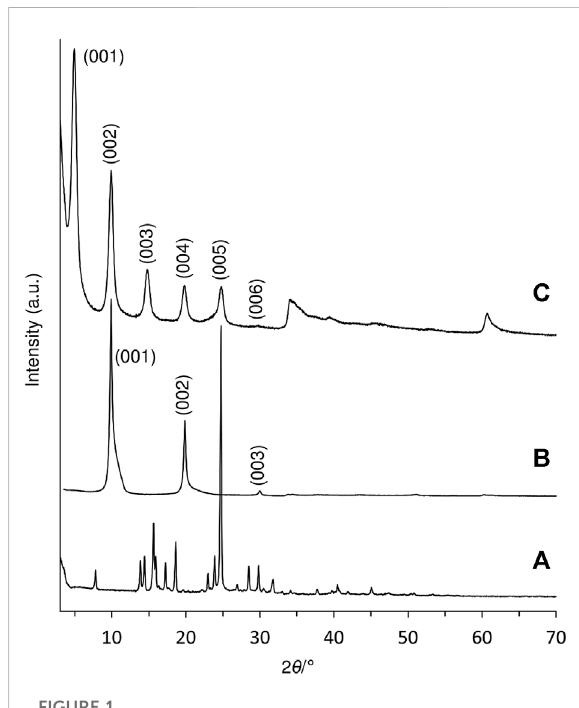
FIGURE 1 PXRDpatternsof (A) ketodiacid 3 , (B) LDH-NO 3 ,and (C) LDH-